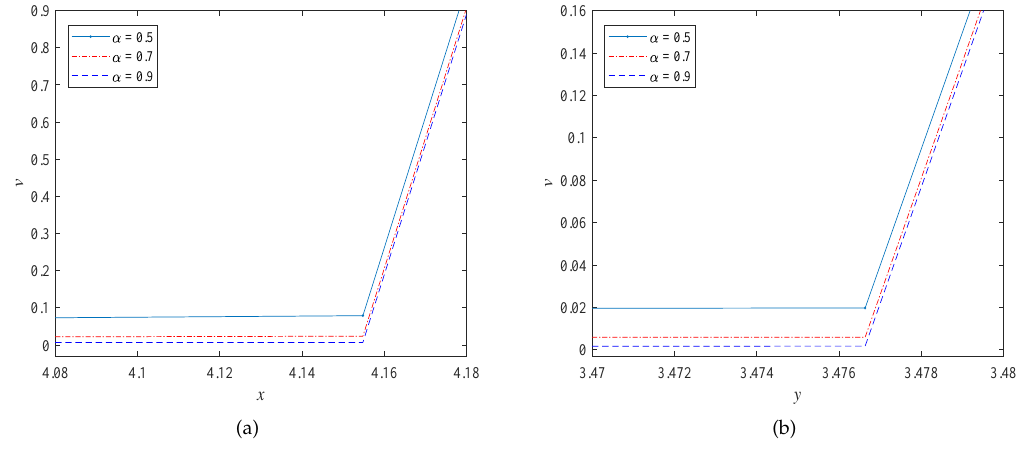
Figure 5. Solution v plots obtained from the model with different orders α = 0.5,0.7,0.9 at a day before an expiration date: ( a ) y = 1.6093; ( b ) x =